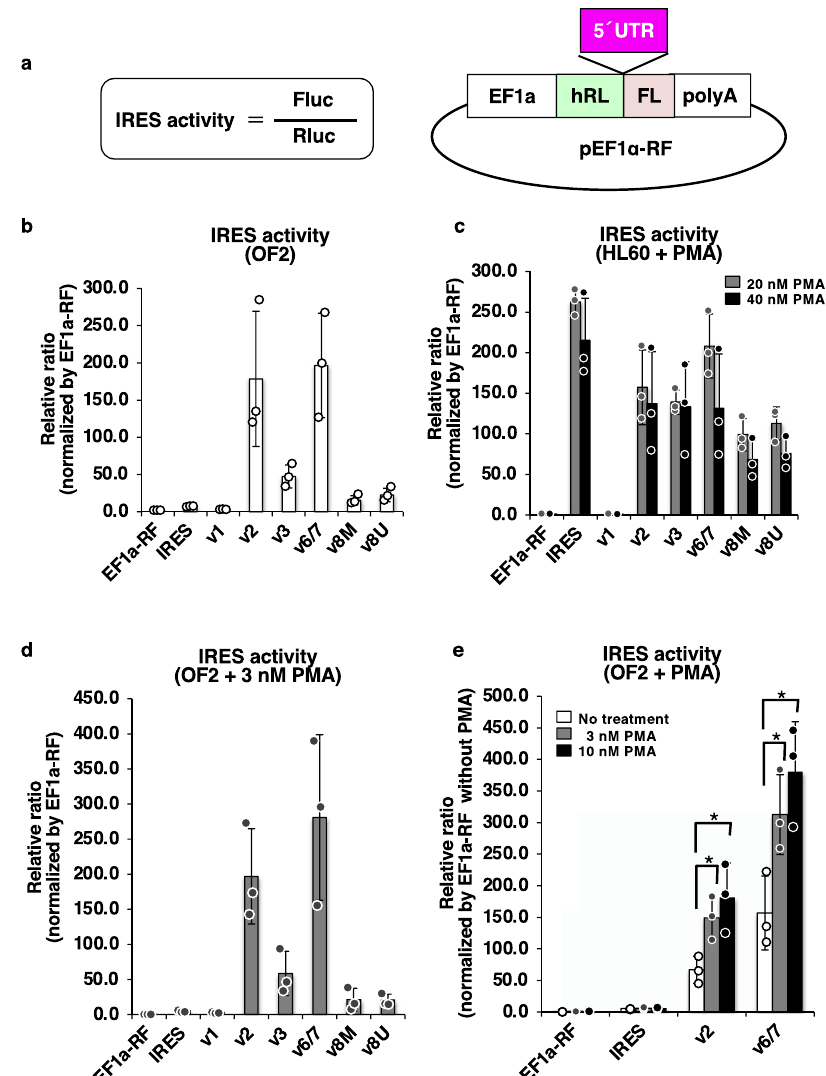
Fig. 6 IRES activity in the 5 ’ UTRs of GBA variants. a Formula for estimation of IRES activity by bicistronic reporter assay and the reporter construct. The 5 ’ UTRs of GBA variants (pink box) were inserted into the pEF1a-RF vector. EF1a, EF1 α promoter; hRL, Renilla luciferase CDS; FL, fi re fl y luciferase CDS. b IRES activity in OFs. c IRES activity in HL60-derived macrophages (HL60 + PMA). Gray bar, 20 nM PMA; black bar, 40 nM PMA. d IRES activity in OFs treated with 3 nM PMA. e Effects of PMA on IRES activity in OFs. White bar, no treatment; gray bar, 3 nM PMA; black bar, 10 nM PMA. Each experiment was performed in triplicate. * p < 0.05. Data represent the mean ±